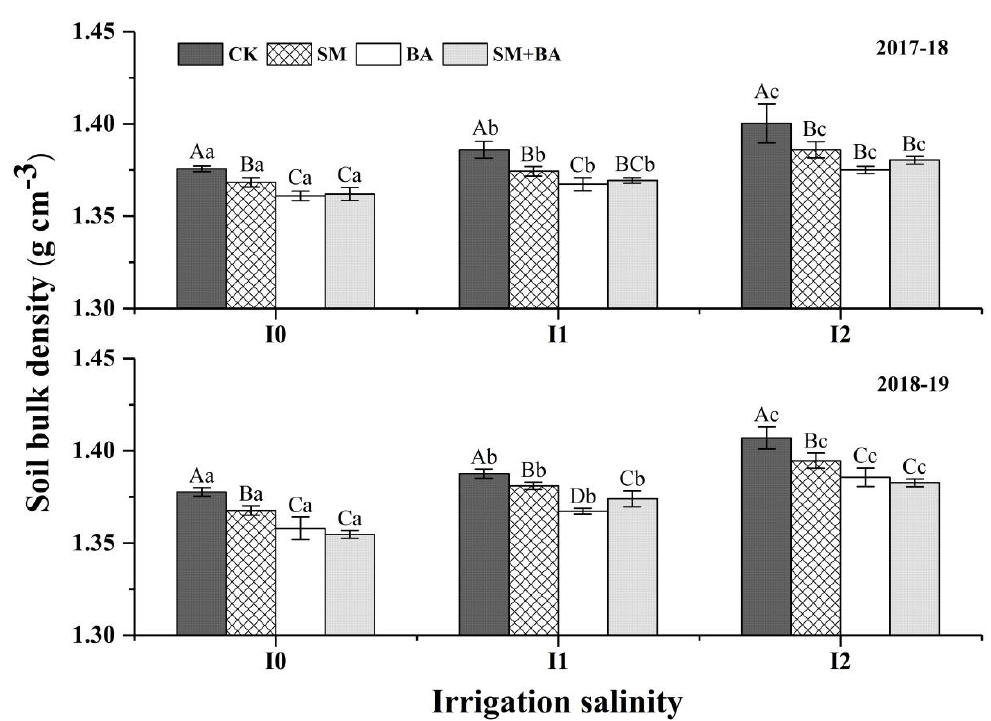
Figure 7. Effects of straw-returning modes and irrigation water salinity on the soil bulk density (BD) in 2017–2018 and 2018–2019, respectively. The values are the means of three replications ± standard deviation. For each growing season, the different uppercase and lowercase letters indicate a significant difference ( p < 0.05) among the straw-returning modes (for a given irrigation regime) and irrigation water salinity levels, respectively. CK: no straw-returning, SM: straw mulching, BA: biochar amendment, SM+BA: straw mulching with biochar amendment; I0, I1, and I2 indicate irrigation salinity levels of 0.47 dS m − 1 , 3.25 dS m − 1 , and 6.75 dS m − 1 ,